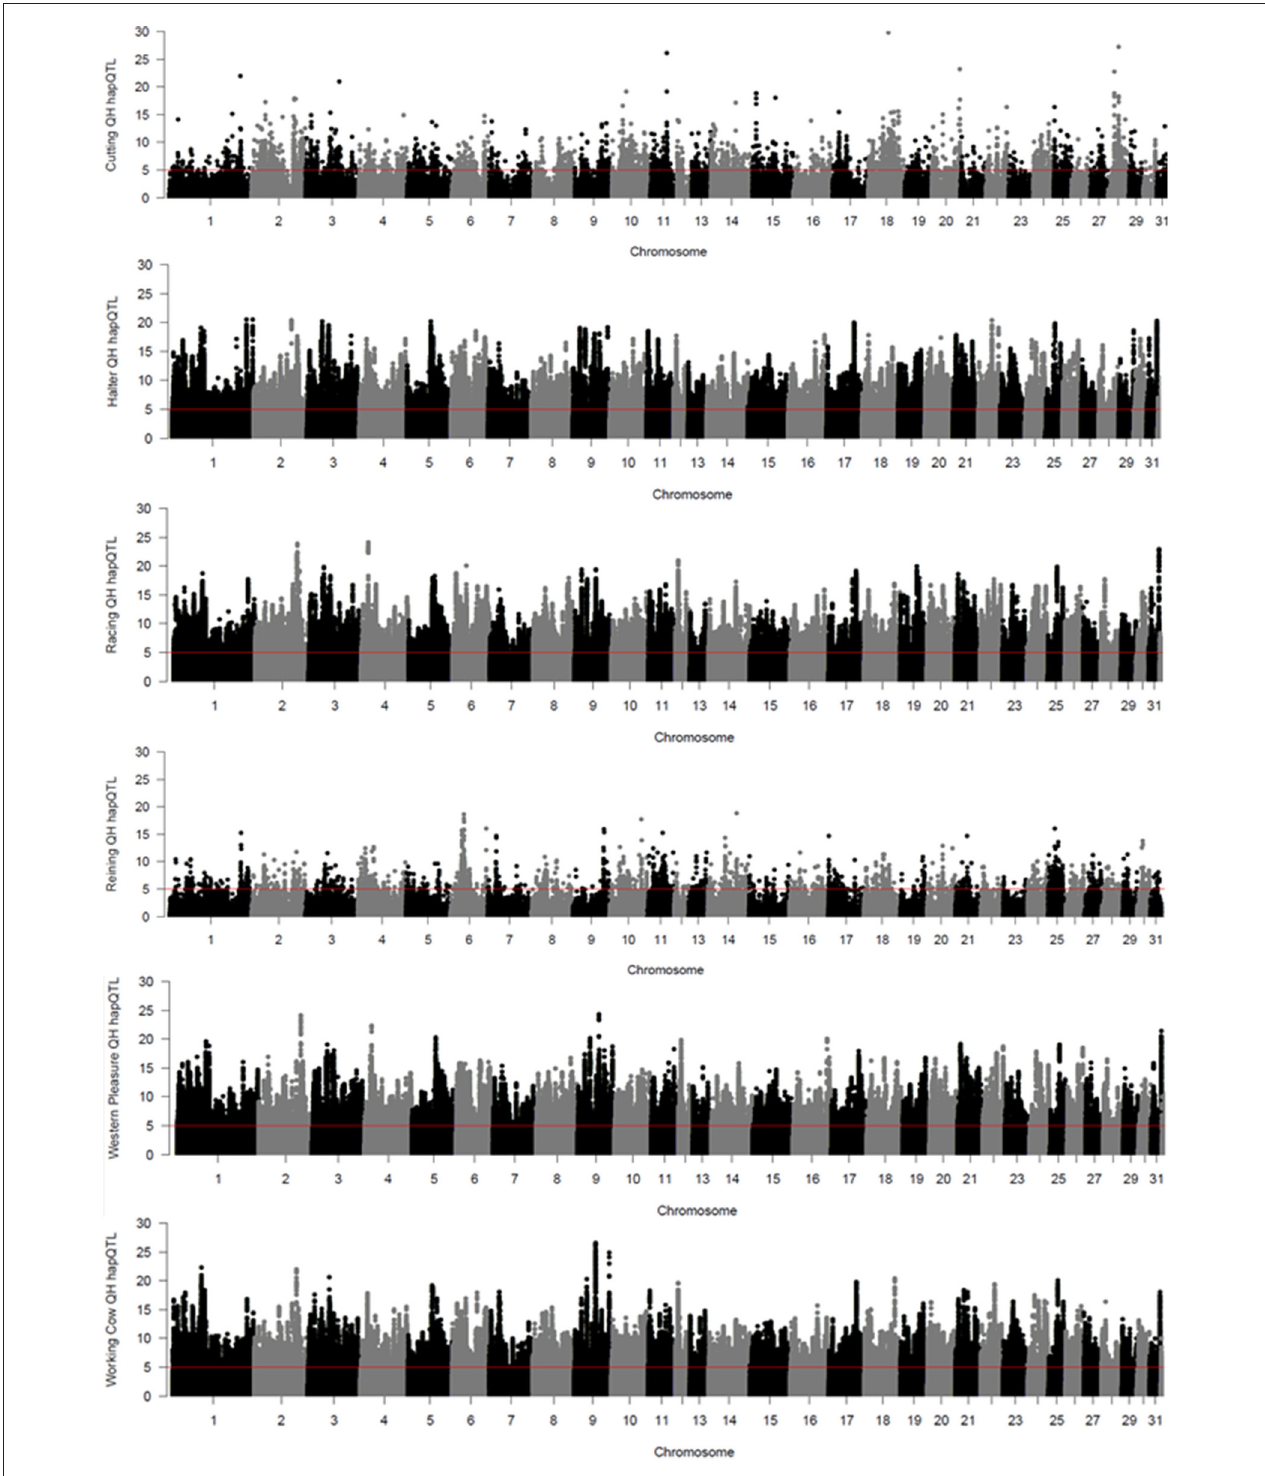
FIGURE 3 | Genome-wide hapQTL values for the 6 QH subpopulations. Bayes factor values for each SNP are plotted on the y axis and each autosome is shown on the x axis in alternating colors.